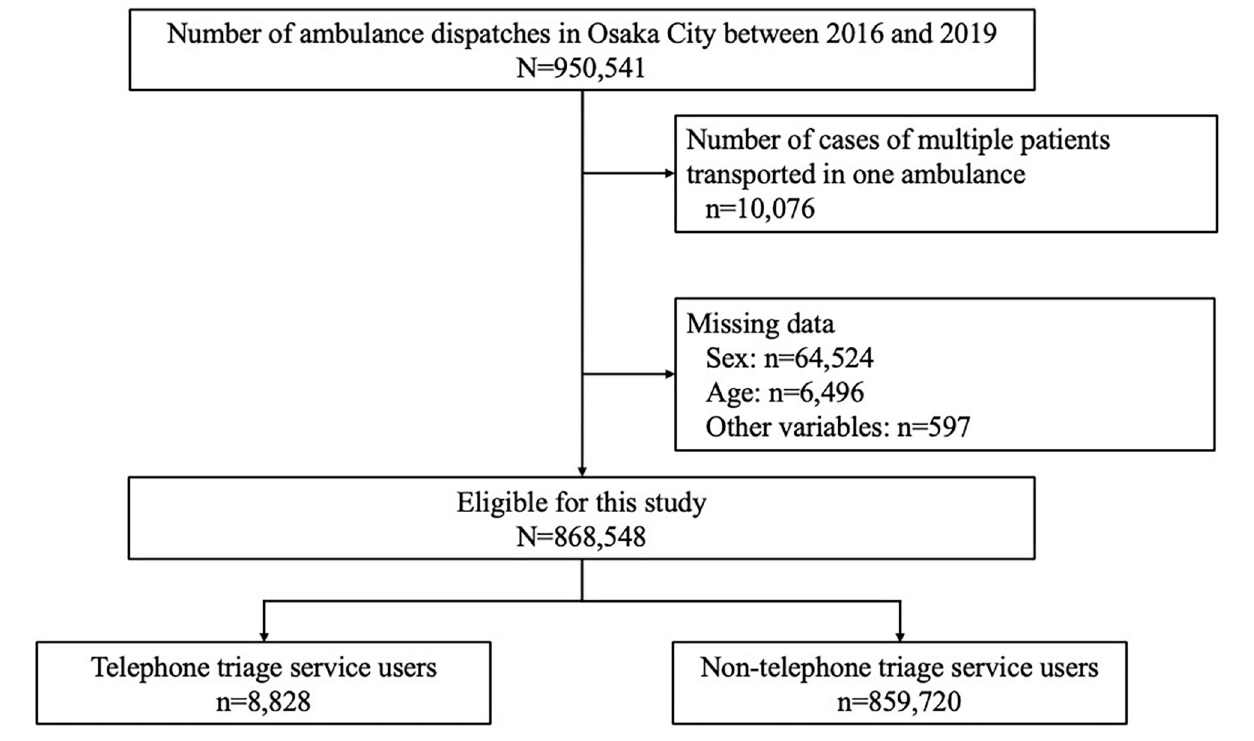
FIGURE 1 | Patient flow in this